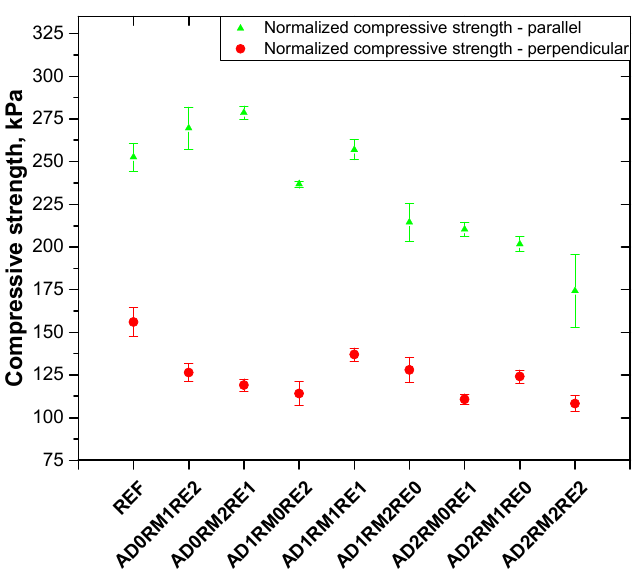
Figure 5. Normalized compressive strength of obtained polyurethane foams.